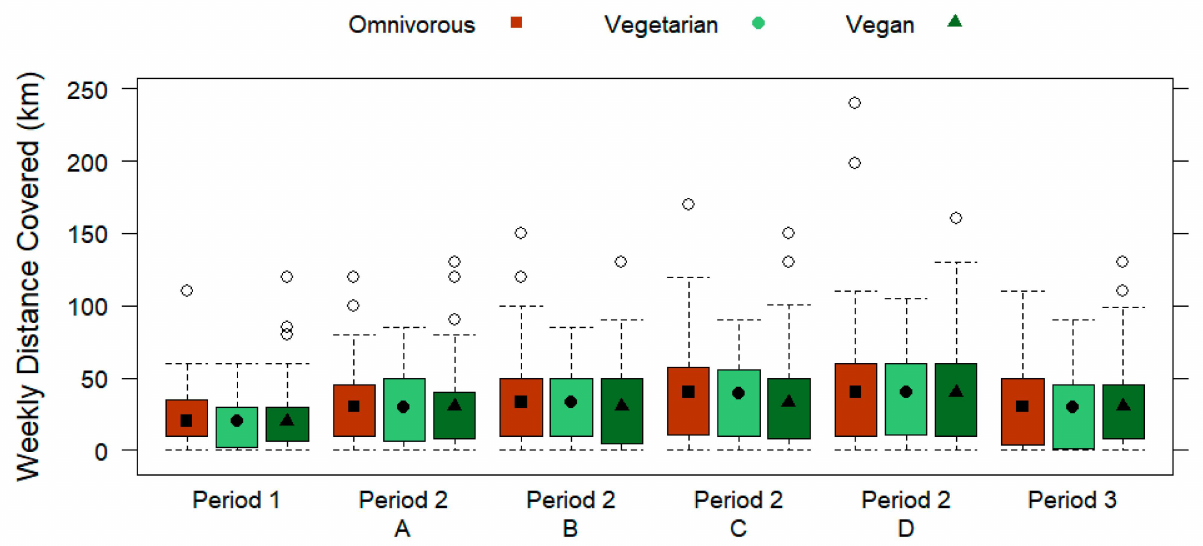
Figure 5. Weekly distance covered (km; displayed by three training periods, including the A, B, C, and D training types of period 2) of omnivorous, vegetarian, and vegan runners. Data are presented by box